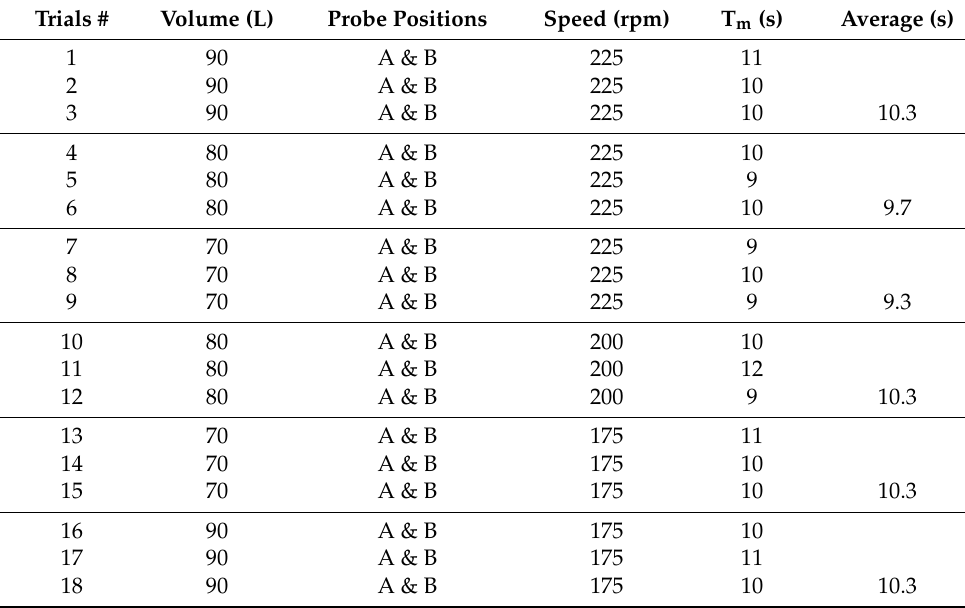
Table 3. Mixing time trials with probe positions in A & B.